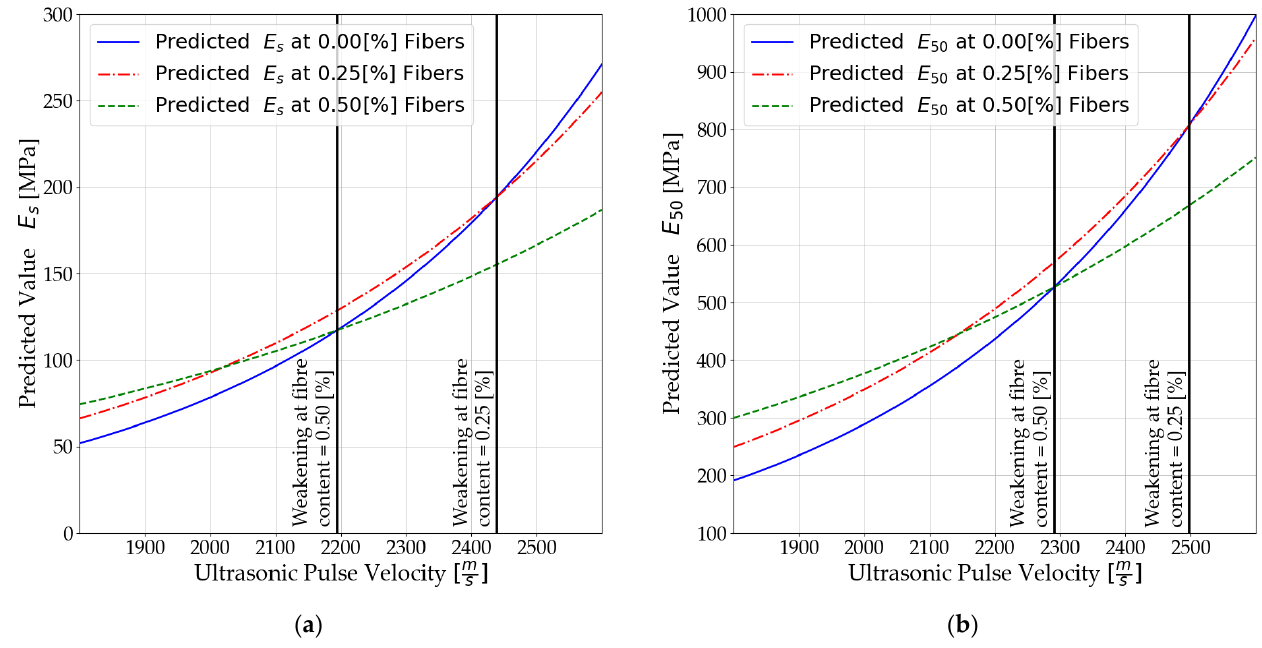
Figure 9. Non-linear relationship between ultrasonic pulse velocity and: ( a ) the 𝐸 𝑠 ; ( b ) the 𝐸 50 .